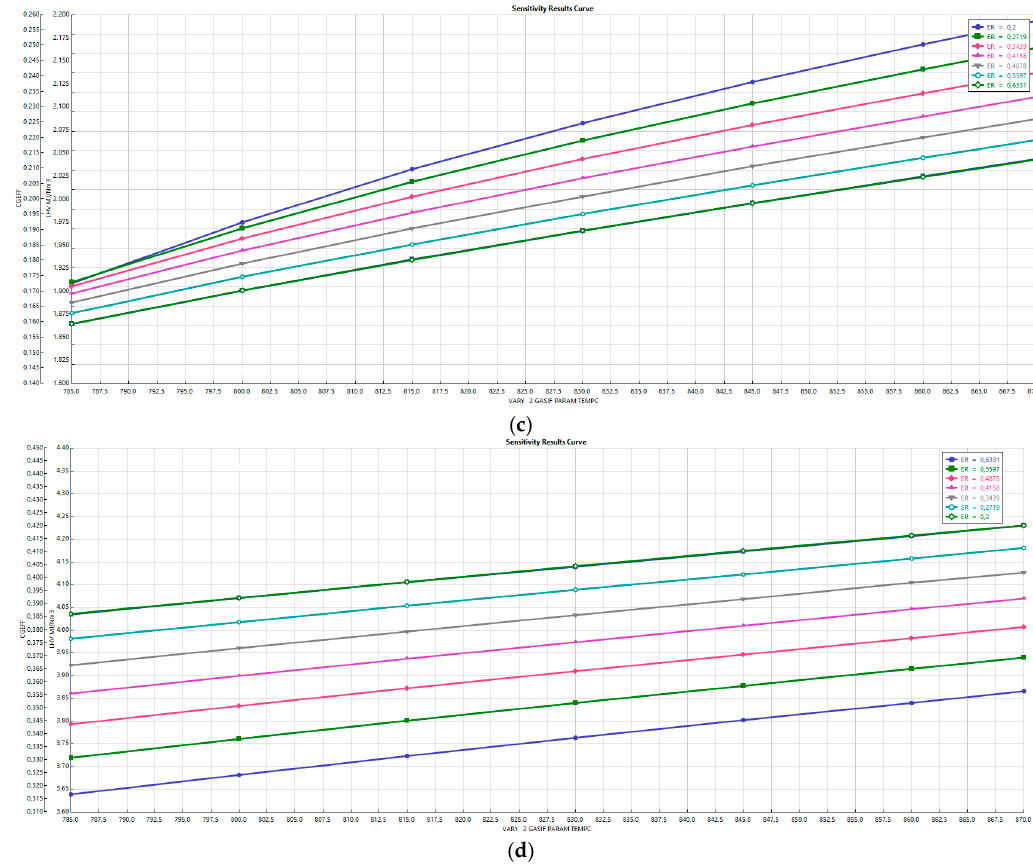
Figure 7. ( a ) Cold gas efficiency and LHV for hazelnut shells. ( b ) Cold gas efficiency and LHV for olive pruning. ( c ) Cold gas efficiency and LHV for olive pomace. ( d ) Cold gas efficiency and LHV for wheat straw.